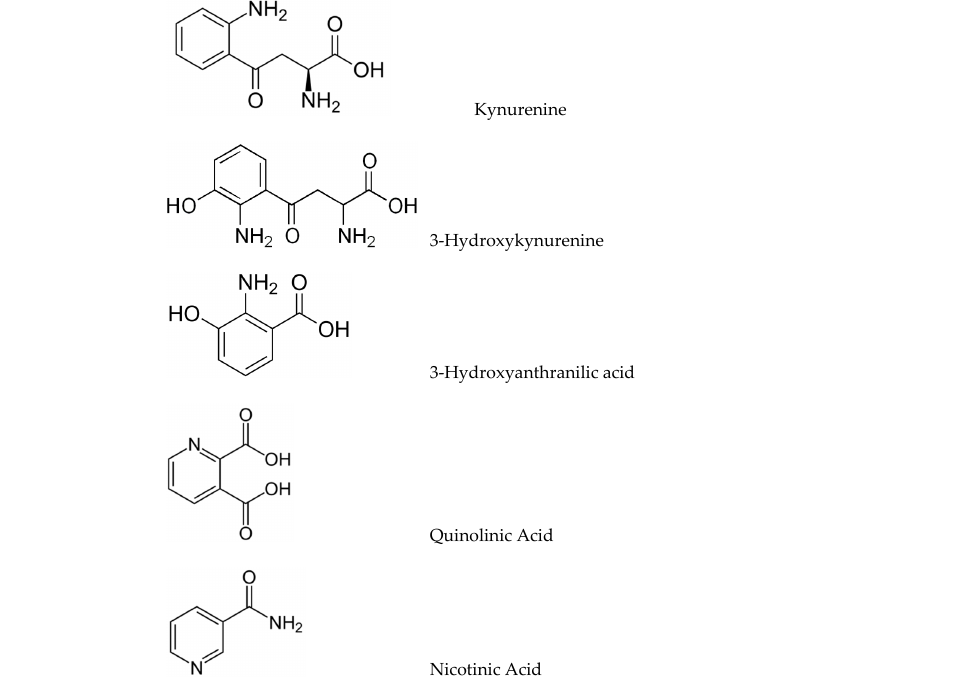
Figure 2. Structures of key kynurenic metabolites.